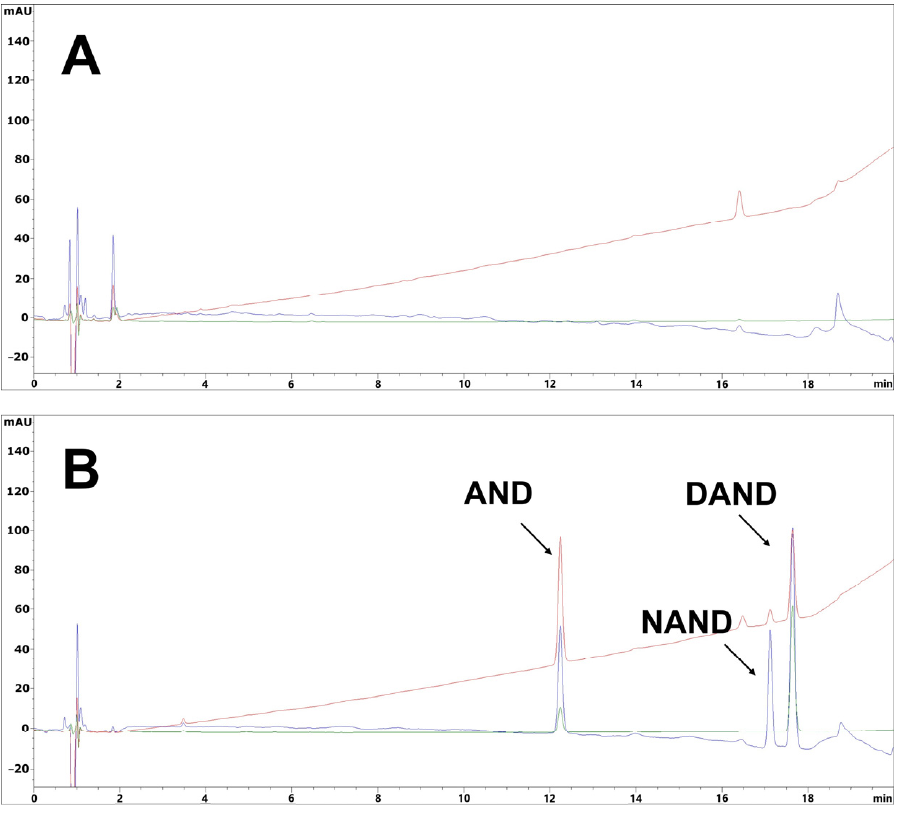
Figure 6. Chromatograms: blank plasma sample ( A ) and spiked plasma sample at ULOQ ( B ). Legend: Chromatogram recorded at 206 nm (blue), 230 nm (red), and 255 nm (green); AND—andrographolide, NAND—neoandrographolide, and DAND—14-deoxy-11,12-didehydroandrographolide. Table 3. Method calibration